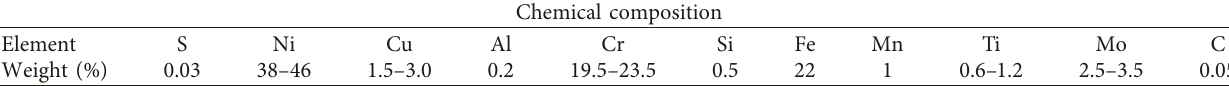
Table 1: Chemical composition of Inconel 825 properties.